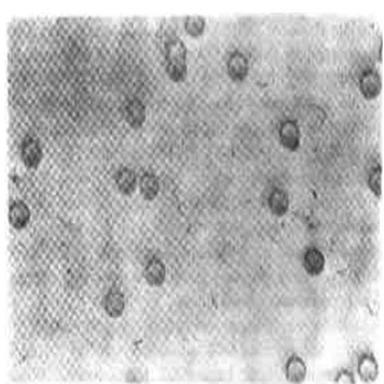
Photomicrograph of 132Xe (14.5 MeV/u) ion track pores (13.3 lm) in Makrofol-KG.